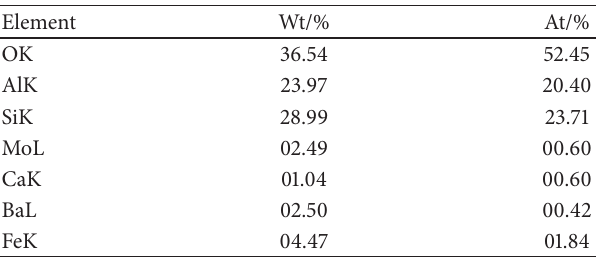
Table 2: The relative percentage of elements of the catalyst particle.